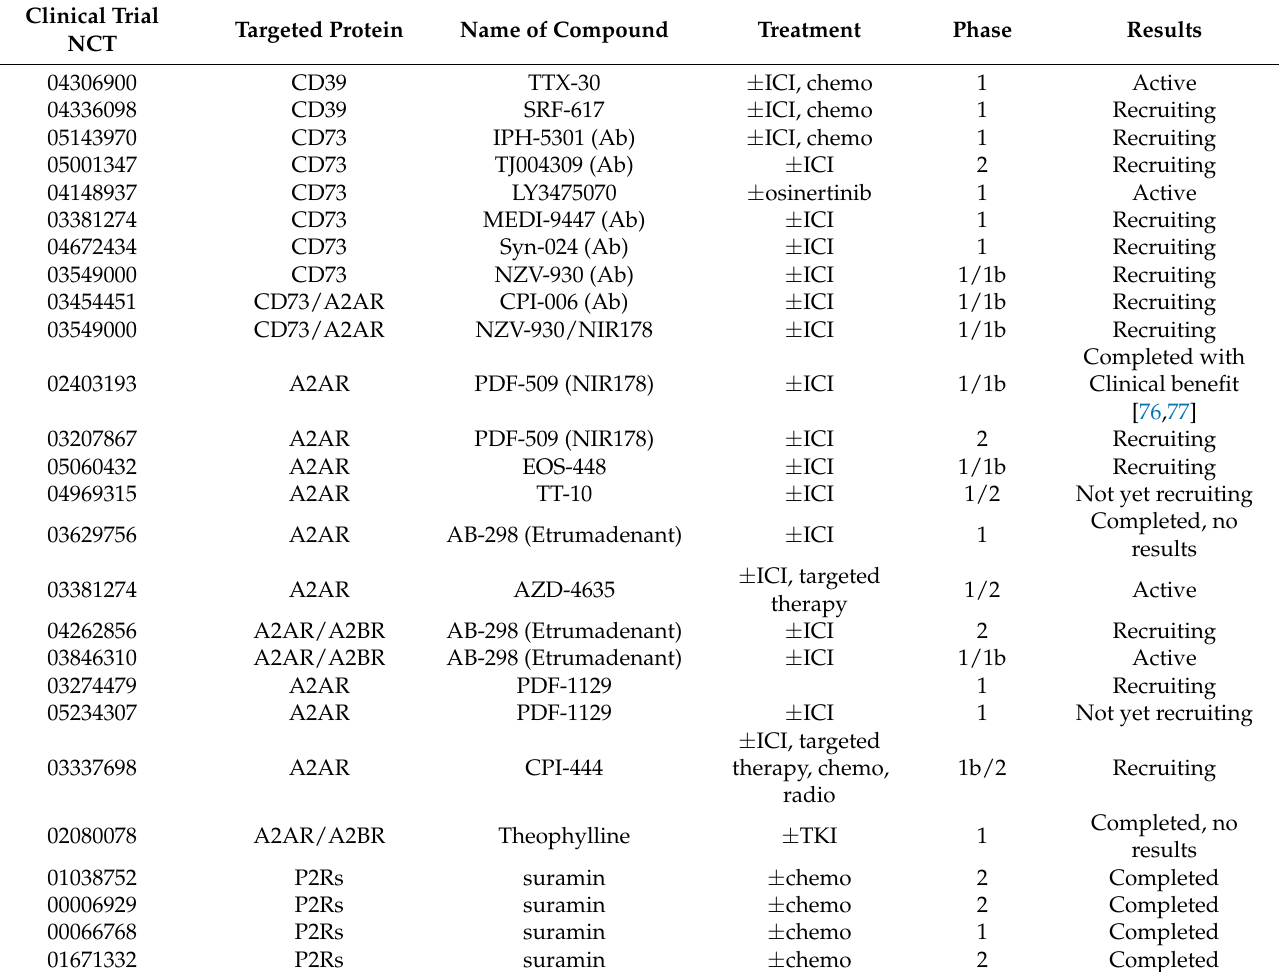
Table 1. Small molecule inhibitors and biologics used against players of the purinergic landscape in clinical trials dedicated to